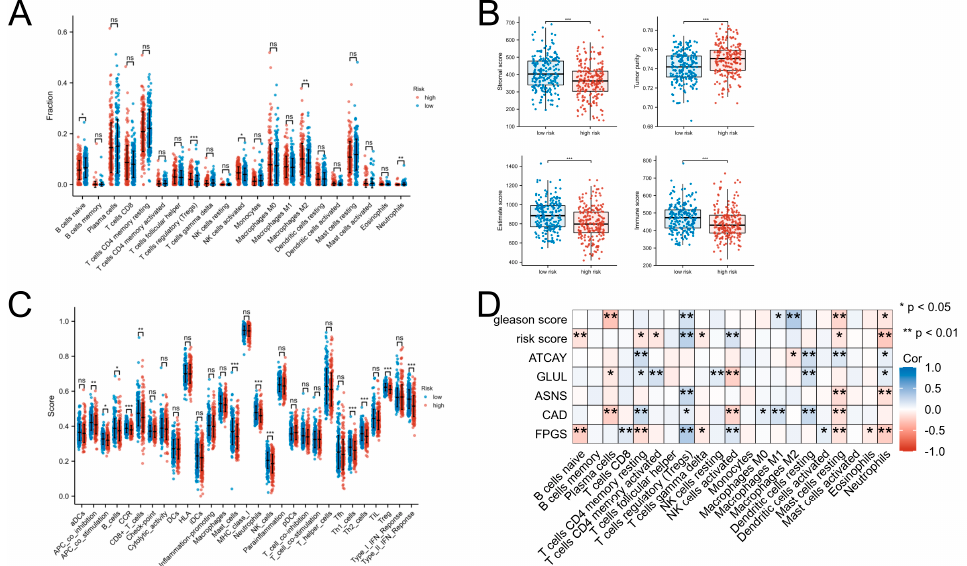
Figure 6. Immune infiltration characteristics in the different risk groups. ( A ) The immune infiltration estimations of the content of 22 immune cells using CIBERSORTx algorithm. ( B ) The immune score, stromal score, estimate score, and tumor purity in high-risk and low-risk groups assessed by the ESTIMATE algorithm. ( C ) The content of 27 immune cells in diverse risk subclasses assessed by the ssGSEA algorithm. ( D ) Correlation analysis of model genes, Gleason score, risk score and immune cells. * p < 0.05, ** p < 0.01, *** p < 0.001, ns represents no significant difference.